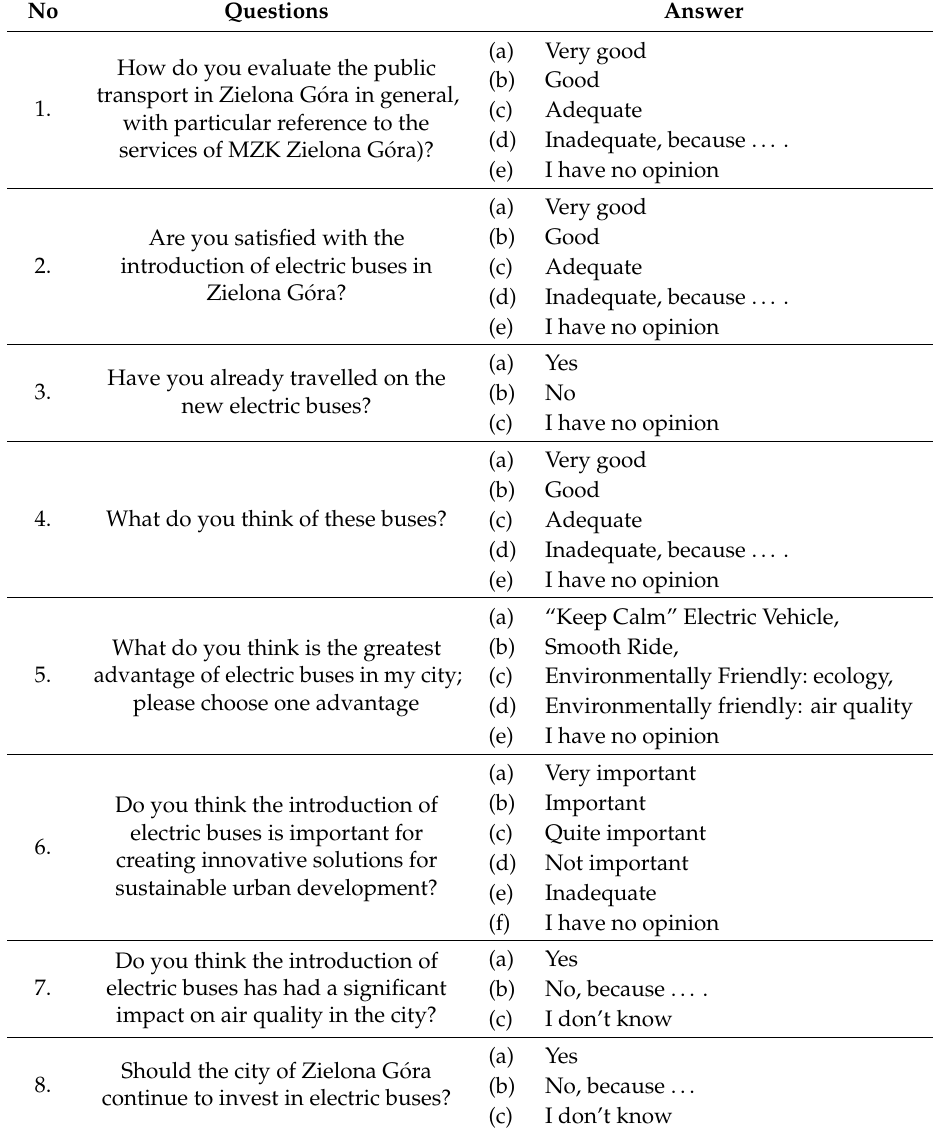
Table A1. The Survey